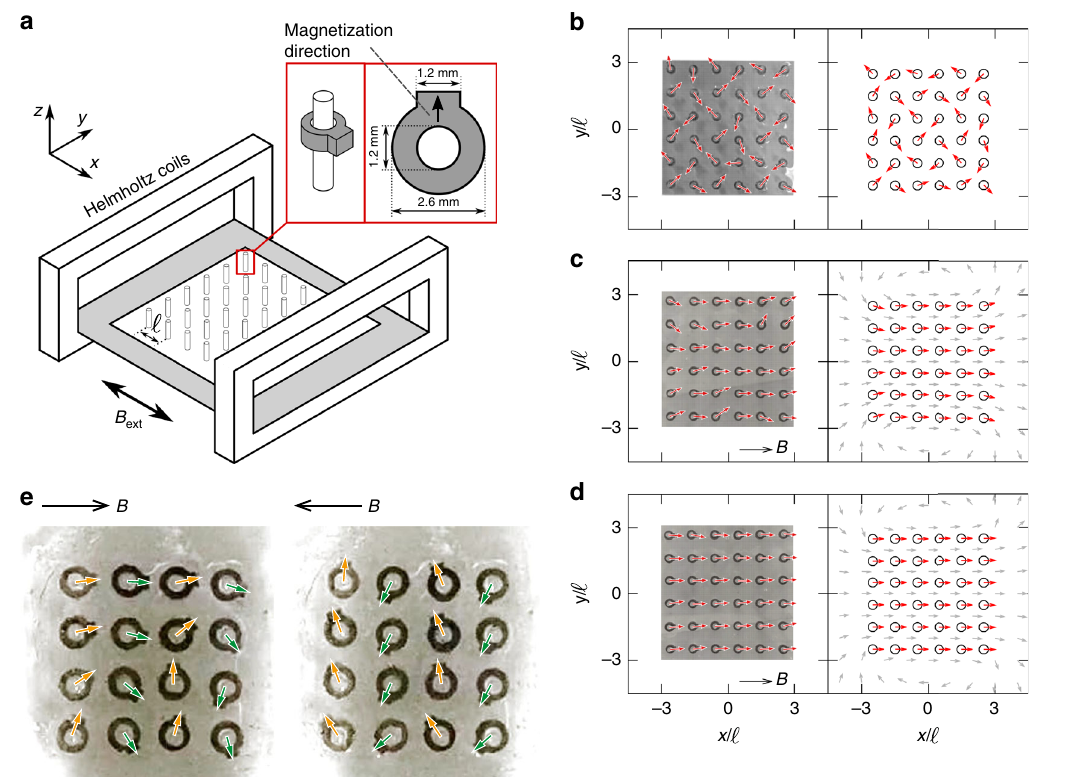
Fig. 2 The array of rotors in static magnetic fi eld and weak oscillating magnetic fi eld. a Schematic of the experimental set-up, consisting of a Helmholtz coil system, with the 3D printed pin system placed in the centre. The inset shows a rotor mounted on a pin and indicates its dimensions. b – d Snapshots of orientational con fi guration under a static fi eld with b α ¼ 0 : 0, c 0.2 and d 10.0. The external magnetic fi eld is imposed to right. Left column shows result from the experiment while right shows the simulation. Red arrows describe the magnetic moment direction, while grey arrows in c , d denotes magnetic fi eld direction created by the rotors. e Experimental observation of the stripe swinging pattern for a 4 ´ 4 rotor array under α ¼ 0 : 4 and β ¼ 0 : 3. The arrows depict the direction of the magnetic moments, and the two frames show the moment when the external magnetic fi eld reached þ B and (cid:2) B ,